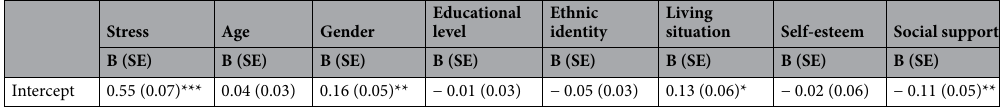
Table 5. Results regression analyses of stress for the whole group (N = 178). *** p < .001; ** p < .01; * p < .05.